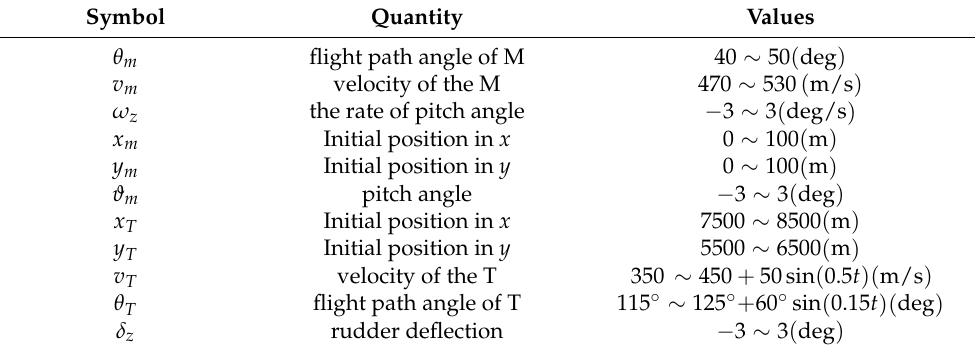
Table 1. The Monte Carlo parameters under case